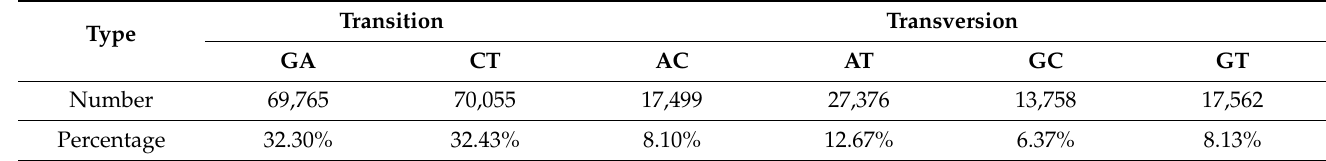
Table 3. Mutation types statistics for 216,015 hypothetical SNPs.